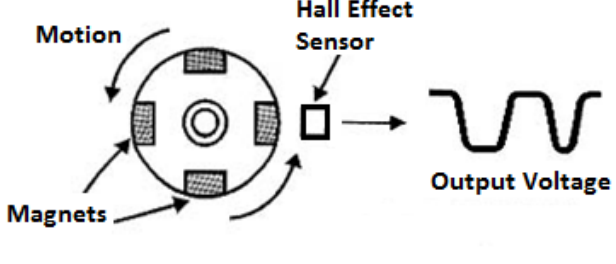
Figure 3. Hall effect sensor under the influence of a magnetic field. Source: Edited by authors.